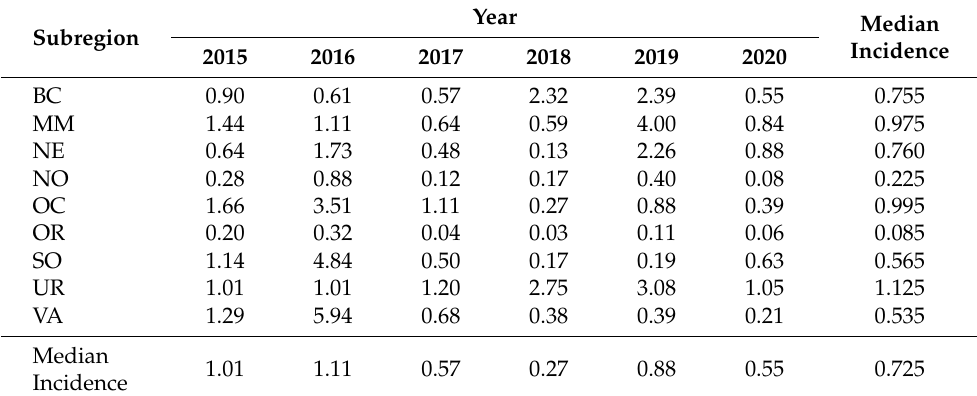
Table 3. Dengue incidence per 1000 inhabitants by subregions between the years 2015 and